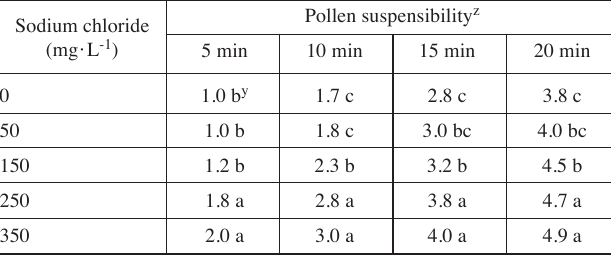
Tab. 1: Effect of sodium chloride concentrations in pollen liquid diluent on the suspensibility by sensory evaluation of ‘Matua’ kiwi pollen.